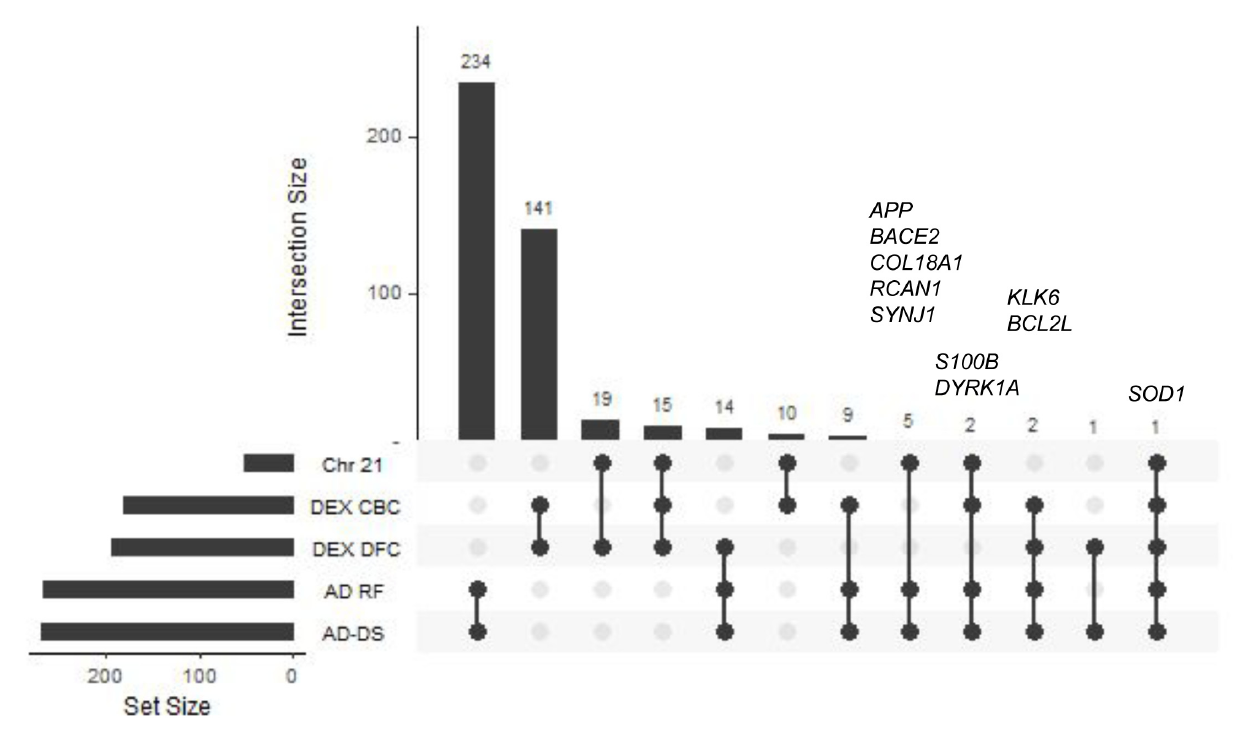
Figure 1. GeneSet overlap. UpSet plot showing geneset overlap highlighting gene content similarity between the AD-DS, Chr21, AD risk factors DEX DFC, and DEX CBC